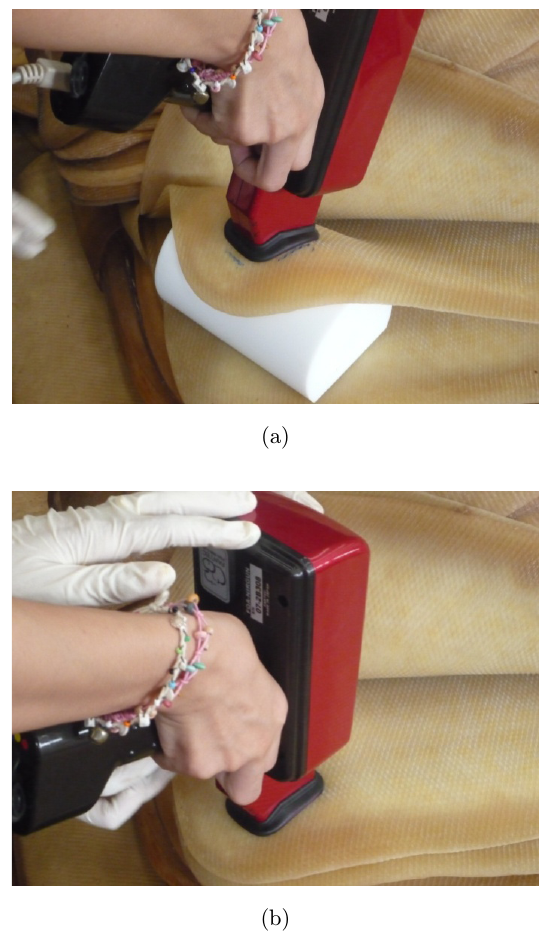
Fig. 1. Spectral acquisition system of single sheet with Te°on under a rubber sheet (a) and a pile of sheets (b). indicate that the predicted values were close to the actual ones. In the single sheet analysis, the mul- tiple correlation coe±cients (R) and the standard error of calibration (SEC) were 0.97 and 0.37%db,